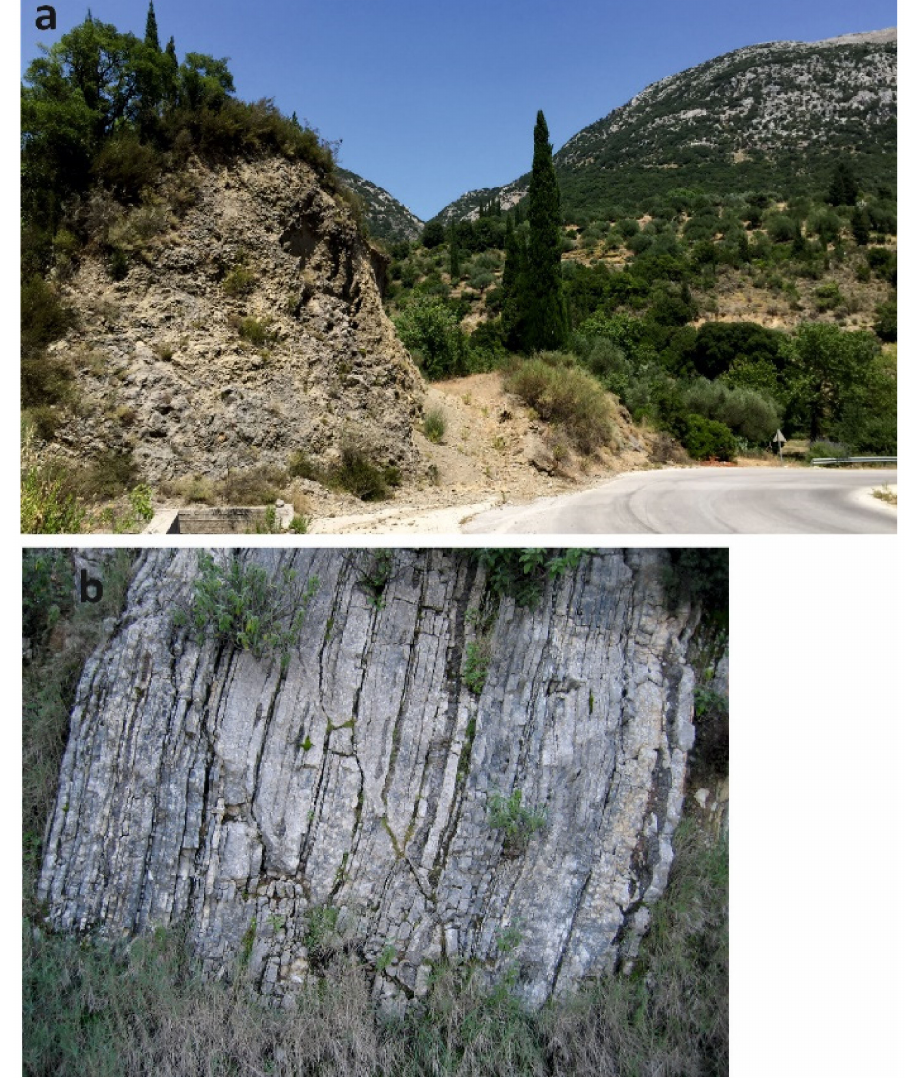
Figure 12. Selected geosites on Kefalonia island, for coding see Figure 4: ( a ) the Ionian thrust (K09) along the road that connects Sami and Poros. Selected geosites on Ithaki island, for coding see Figure 4; ( b ) the Vigla Shale Member outcrop, Ionian unit sequence, at the area of Vathy (I06). Photos courtesy ( a ) M.V. Triantaphyllou, I. Mikellidou, ( b ) M.V.